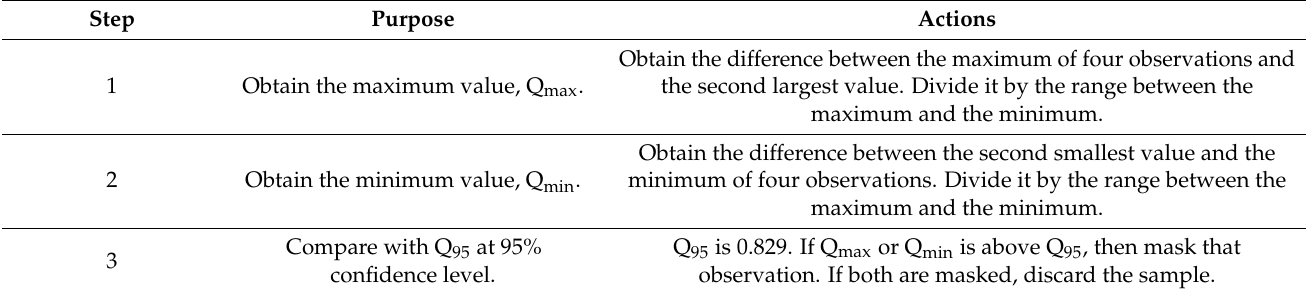
Table 4. Algorithm for conducting Dixon’s Q test to detect sample outliers.